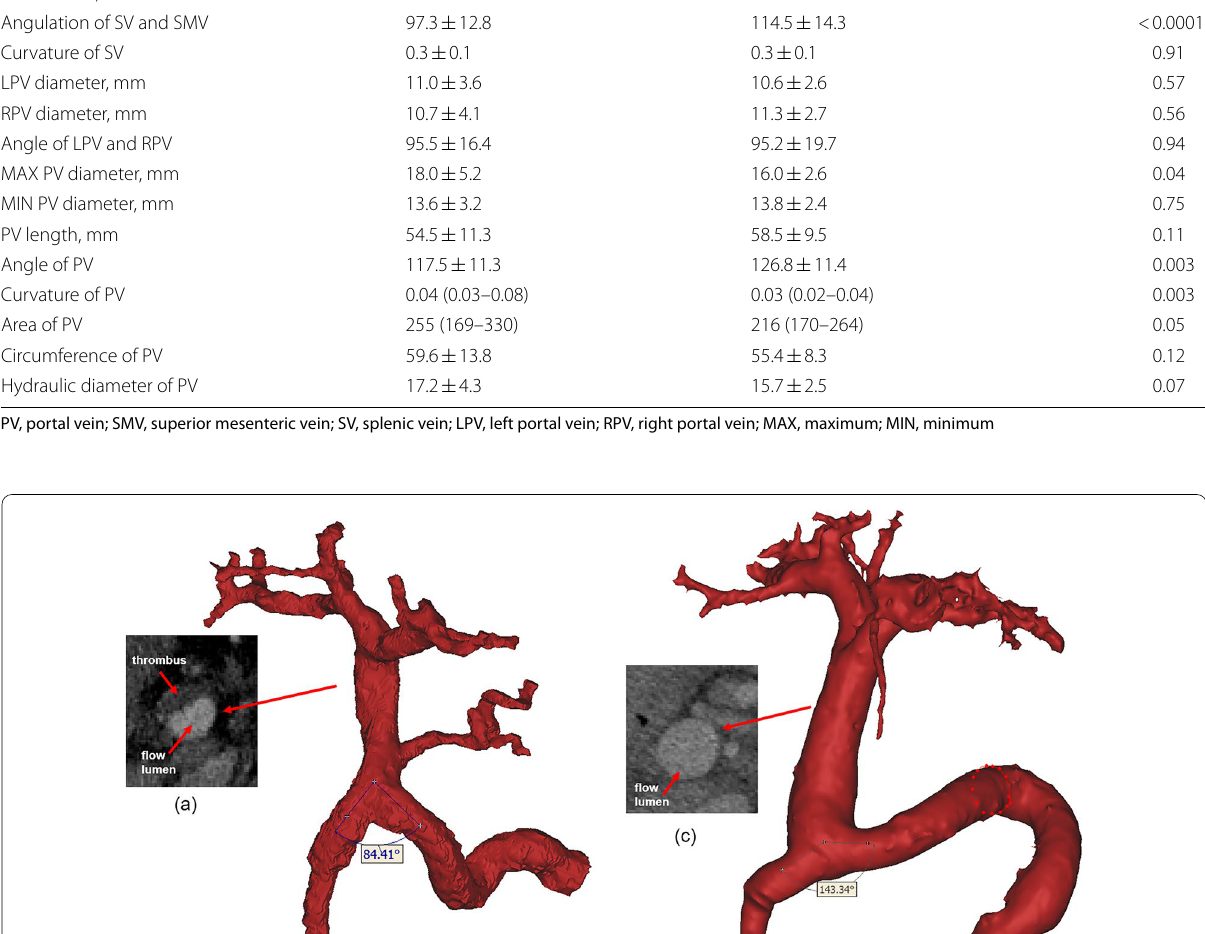
36) Without PVT ( n =